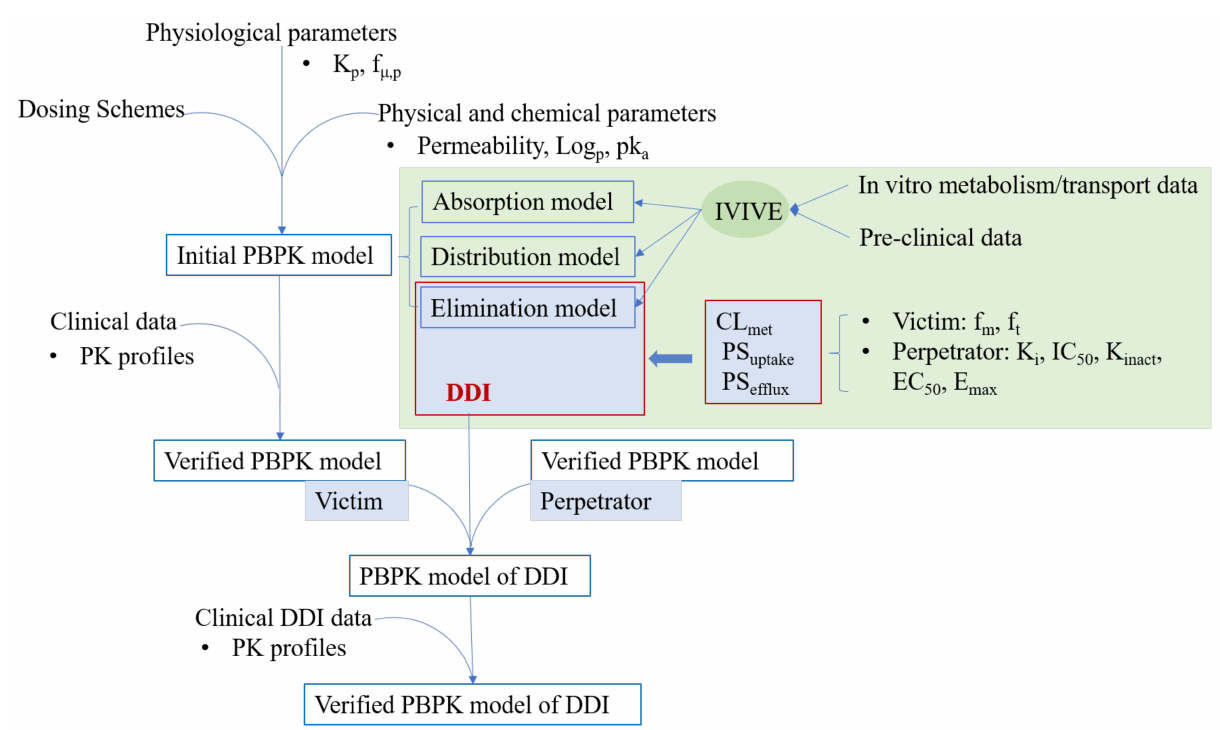
Figure 3. Workflow of PBPK modeling for the prediction of cytochromes P450 (CYP)/transporter-mediated